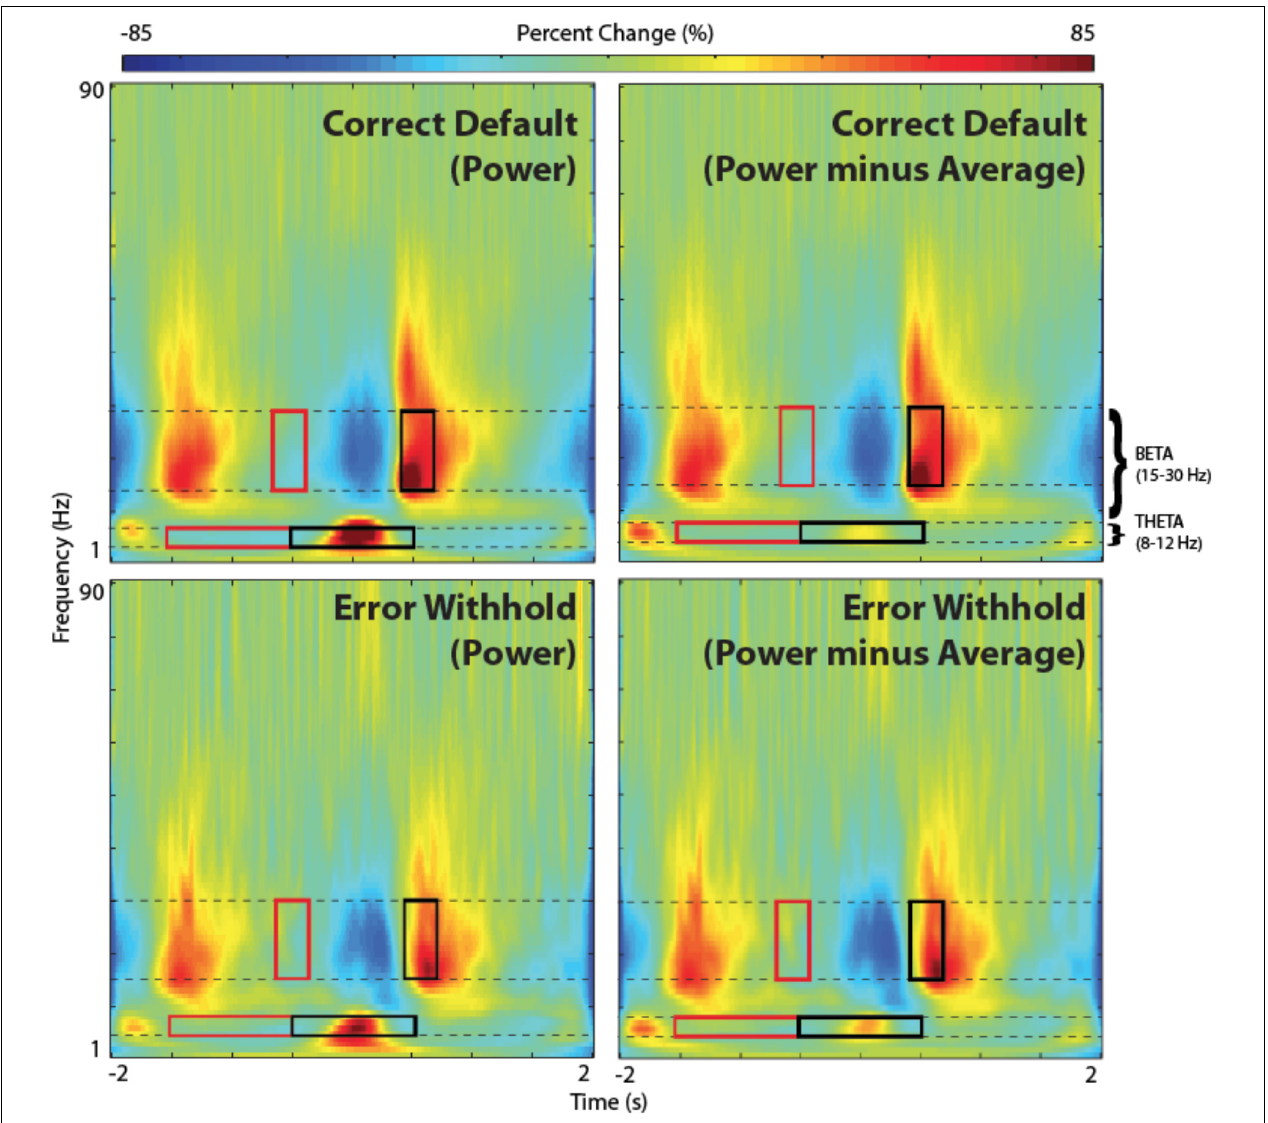
FIGURE 6 | Time-frequency representations (TFR). TFR plots are useful as an aid in the identification of appropriate baseline and active windows for SAM beamformer analyses. Here, we demonstrate the chosen baseline window (red) and active window (black) within the beta band frequency (15–30 Hz), as well as suggested windows for theta band frequency (4–8 Hz), for a group SAM motor peak analyses. Time zero indicates button press. Note that removing the averaged evoked activity (power-average dropdown option within BrainWave ) shows only non-phase locked activity, resulting in reduced power in both beta and theta bands. However, larger reductions are found in theta and remains higher in the error